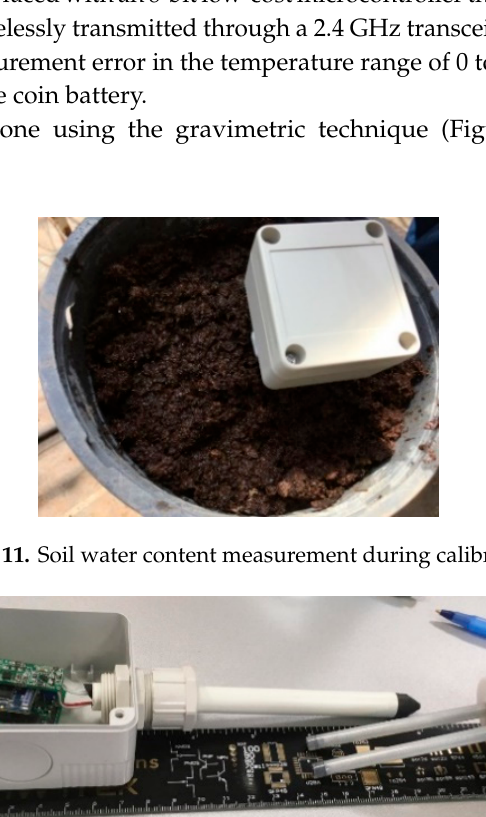
Figure 10. Simulation of the electric field and capacitance computing using COMSOL Multiphysics.